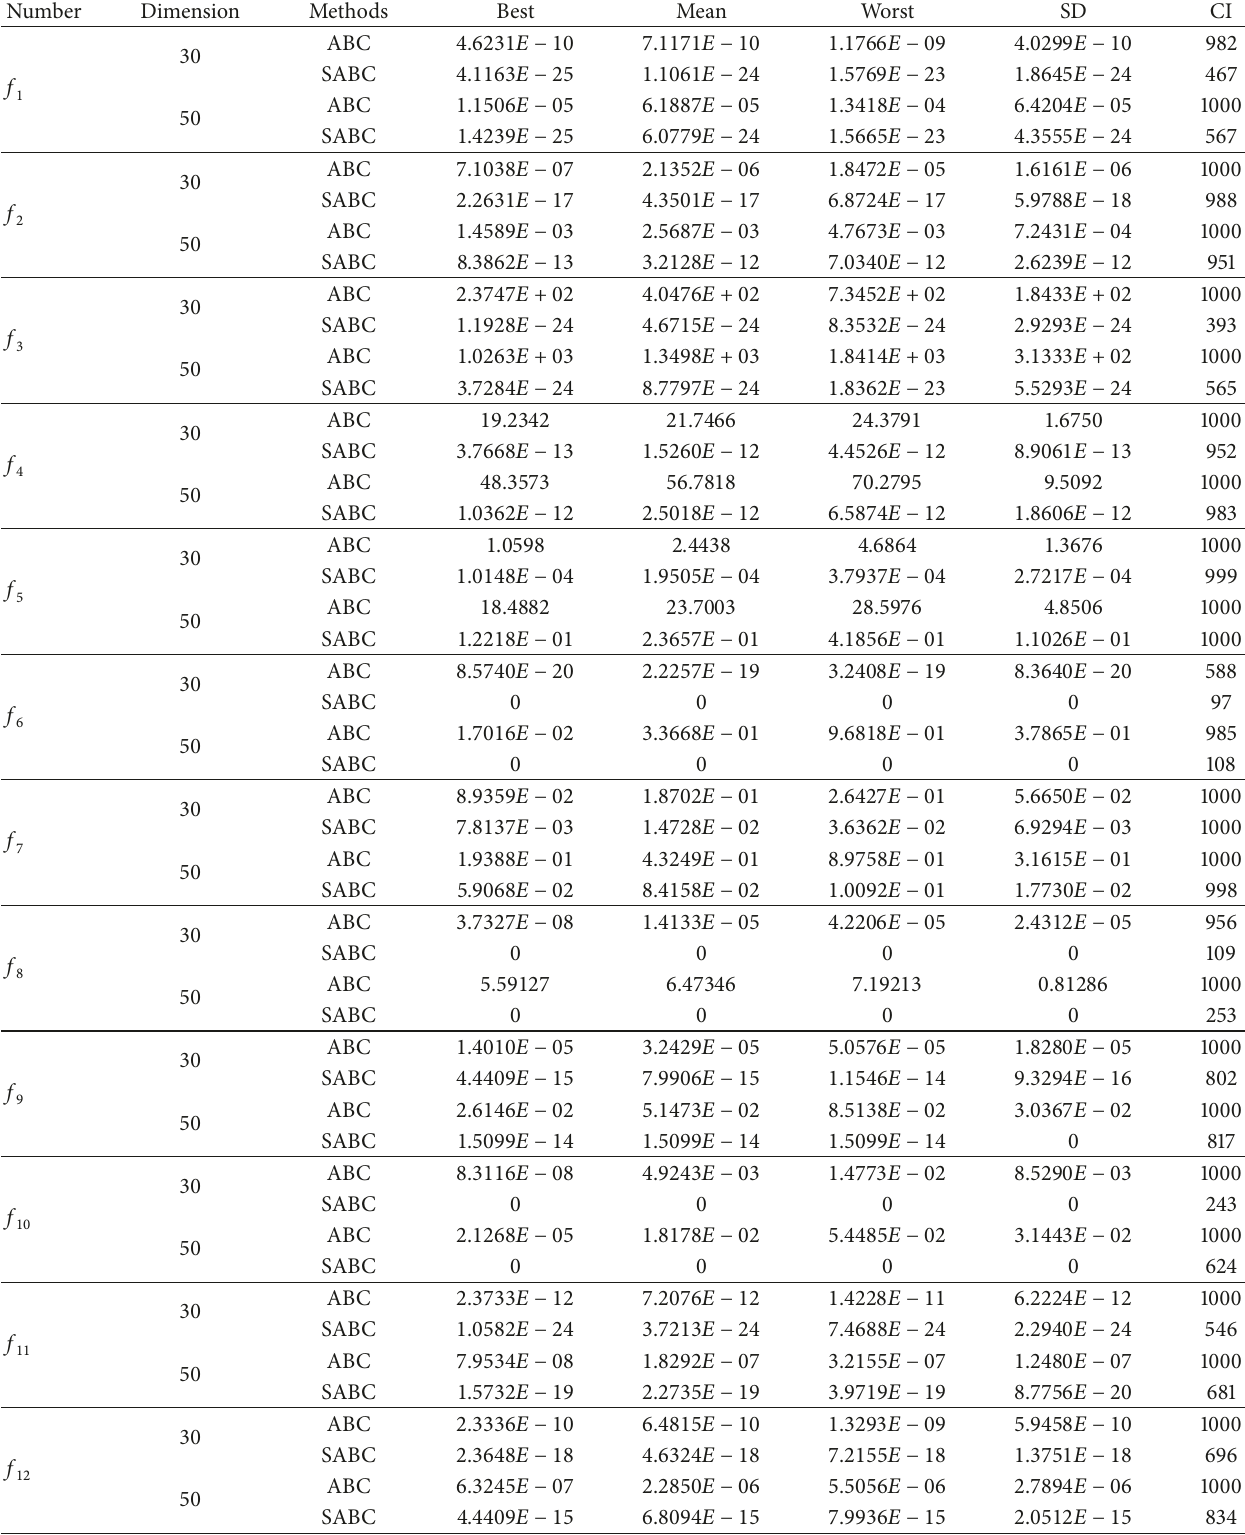
Table 2: Experimental results of SABC and ABC in 𝑓 1 – 𝑓 12